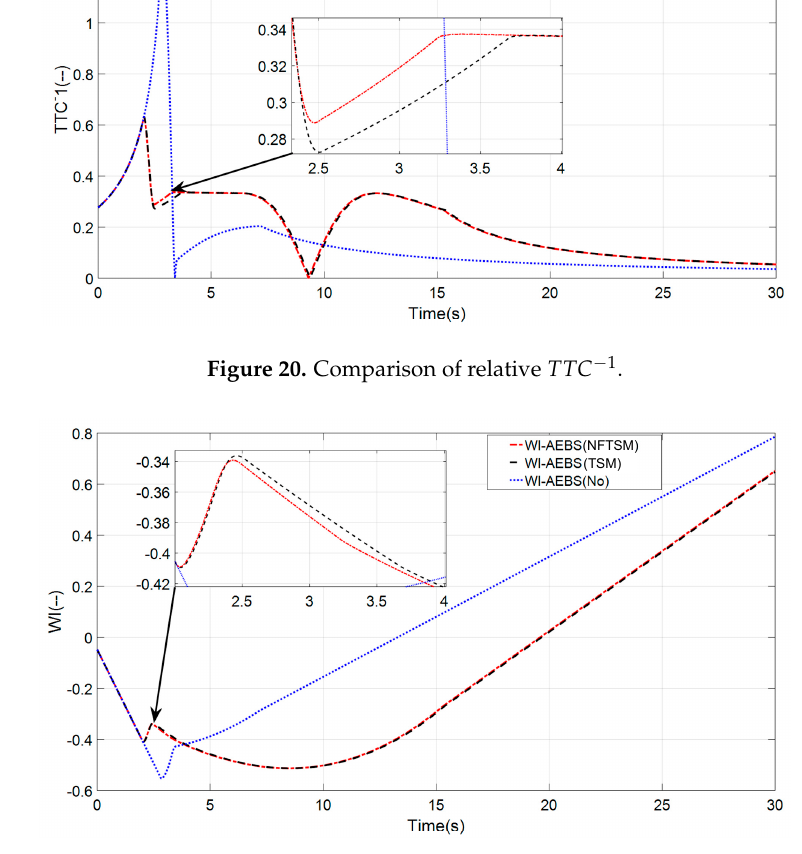
Figure 21. Comparison of relative WI .